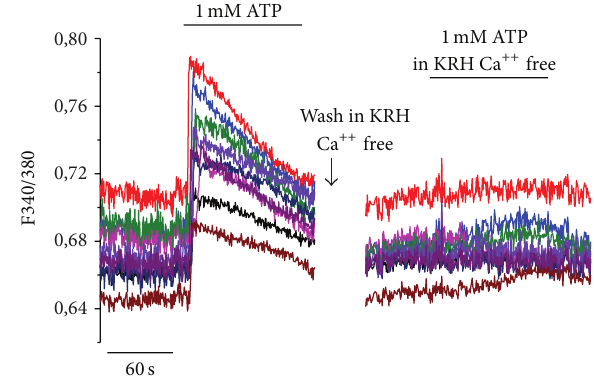
Figure 6: P2X but not P2Y-dependent response of fibroblast- like synovial cells exposed to synovial fluid. Representative graph showing kinetics of response of FLS exposed to SF pool 1 for 7 days. It is very interesting to observe that after 7 days, all RA FLS exposed chronically to SF respond to ATP exposure. When the experiment is replicated in the absence of extracellular calcium, the functional response is completely abolished. This suggests that the ATP medi- ated response of FLS is due to P2X and not P2Y